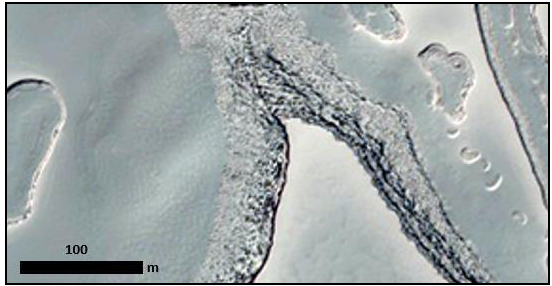
Figure 2: Close up of terraced scarp in SCT depression (HiRISE: PSP_004753_0930